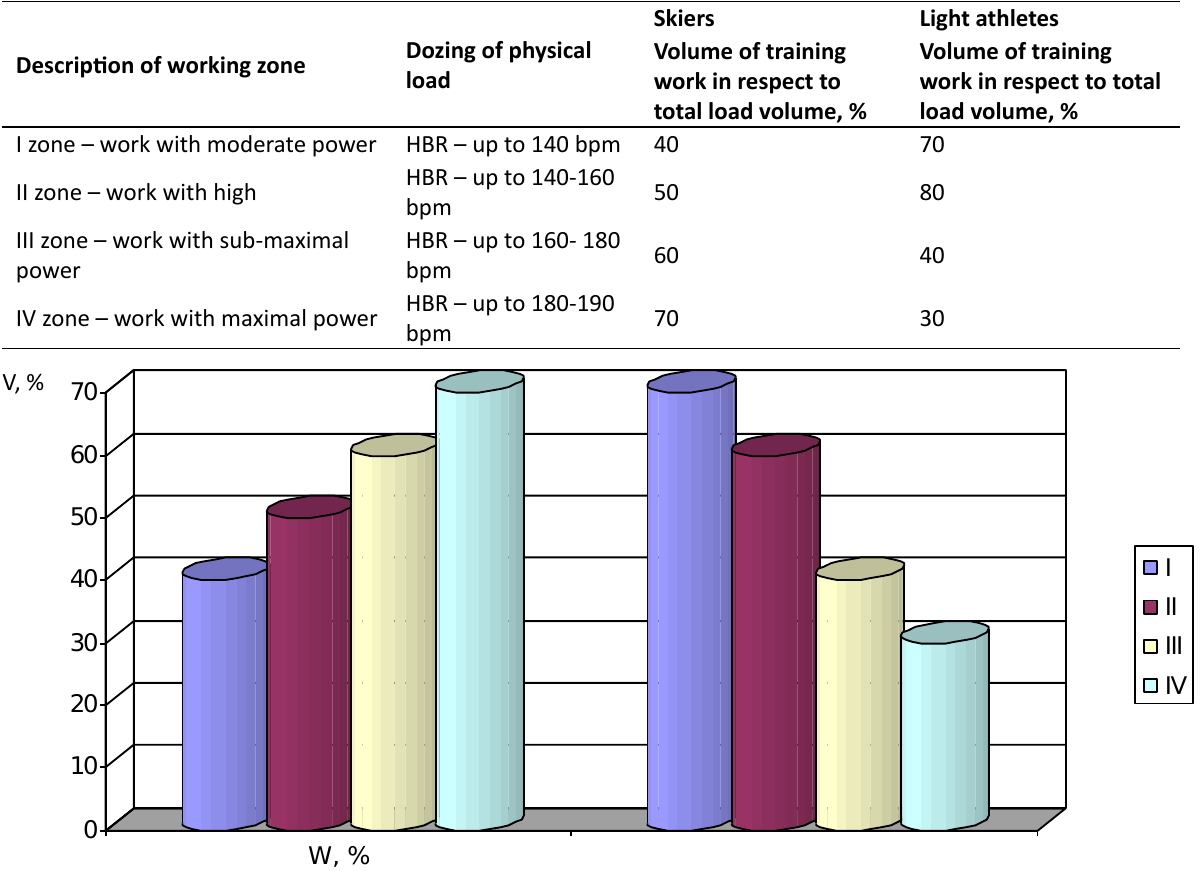
Fig. 3. Distribution of physical load in light athletic sportsmen’s and skiers’ annual training plan: I, II, III, IV – zones of work; V – volume of cyclic load; I zone – work with moderate power; II zone – work with high power; III zone – work with sub-maximal power; IV zone – work with maximal power; W, % - volume of training work in respect to total load